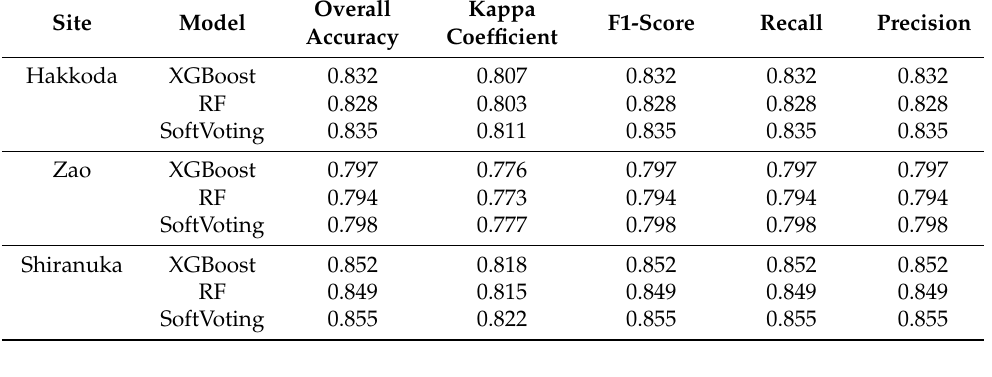
Table 6. Performance of the ultra-resolution suite using bi-seasonal images.